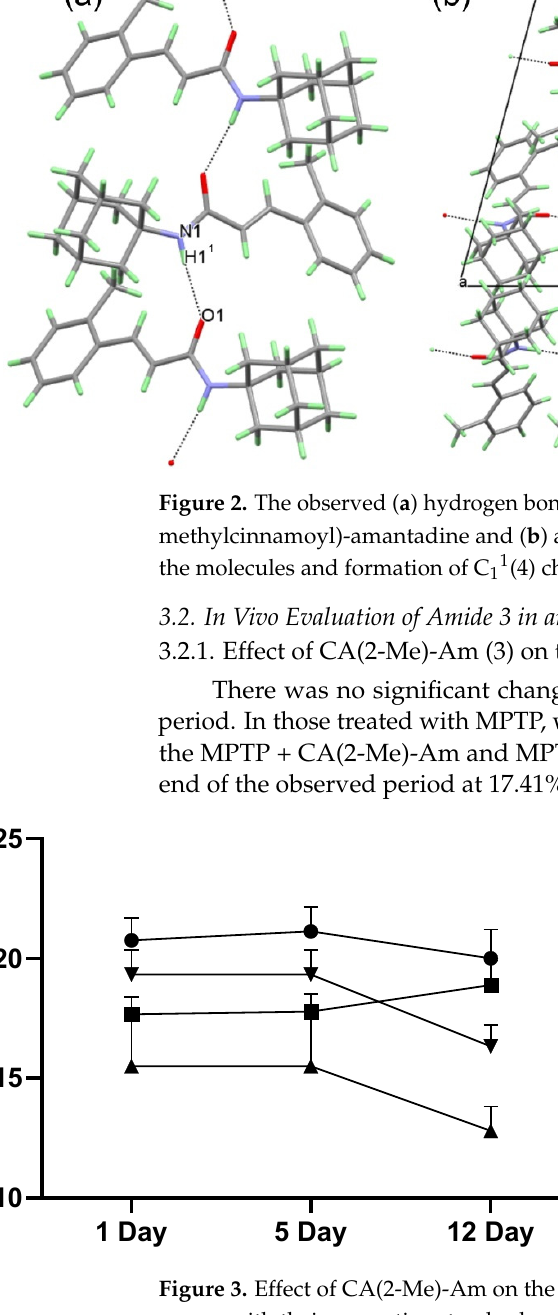
Figure 4. Effect of CA(2-Me)-Am on neuromuscular coordination. The asterisks above bars indicate significant differences in number of falls per minute for each experimental group versus the control at * p < 0.05. Statistical analysis was performed by one-way analysis of variance (ANOVA) followed by Dunnett’s post hoc comparison test. 3.2.3. Passive Avoidance Test The administration of the MPTP toxin caused a decrease in the step-through latency time by 31.56% ( p < 0.01) at 1st h and by 33.45% ( p < 0.01) at 24th h after the training of mice as compared to controls, which is evidence of memory and learning deficits. Admin- istration of CA(2-Me)-Am increased the latent reaction time by 33.49% ( p < 0.05) at the 1st h and by 33.84% ( p < 0.05) at 24th h as compared to the MPTP-treated group, an indication of a memory-protective effect of the newly synthesized amantadine derivative (Figure 5).